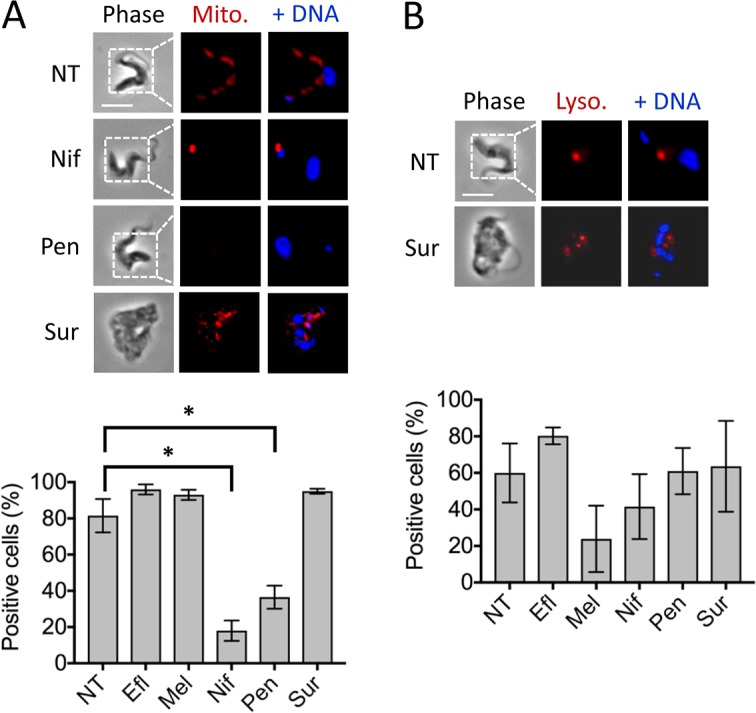
Assessment of mitochondrial and lysosomal phenotypes.(A) The microscopy images show examples of the Mitotracker signals. Percentage of cells positive for the typical ‘extended’ Mitotracker signal are shown. *, P < 0.05 from Students t-test. (B) The microscopy images show examples of the Lysotracker signals observed in untreated and suramin-treated cells. Percentage of cells positive for Lysotracker signal are shown. Other details as in Fig 2A; error bars, SD; N = 2; scale bars, 5 μm except for suramin-treated cells, which are 10 μm.